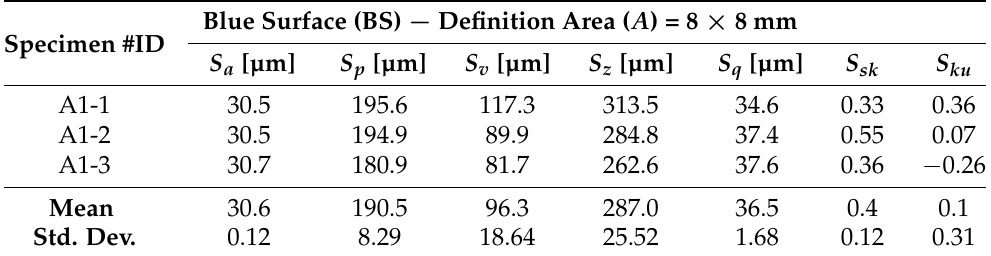
Table 5. Assessment of the repeatability of the SLM production process: blue surface (BS). Specimen #ID